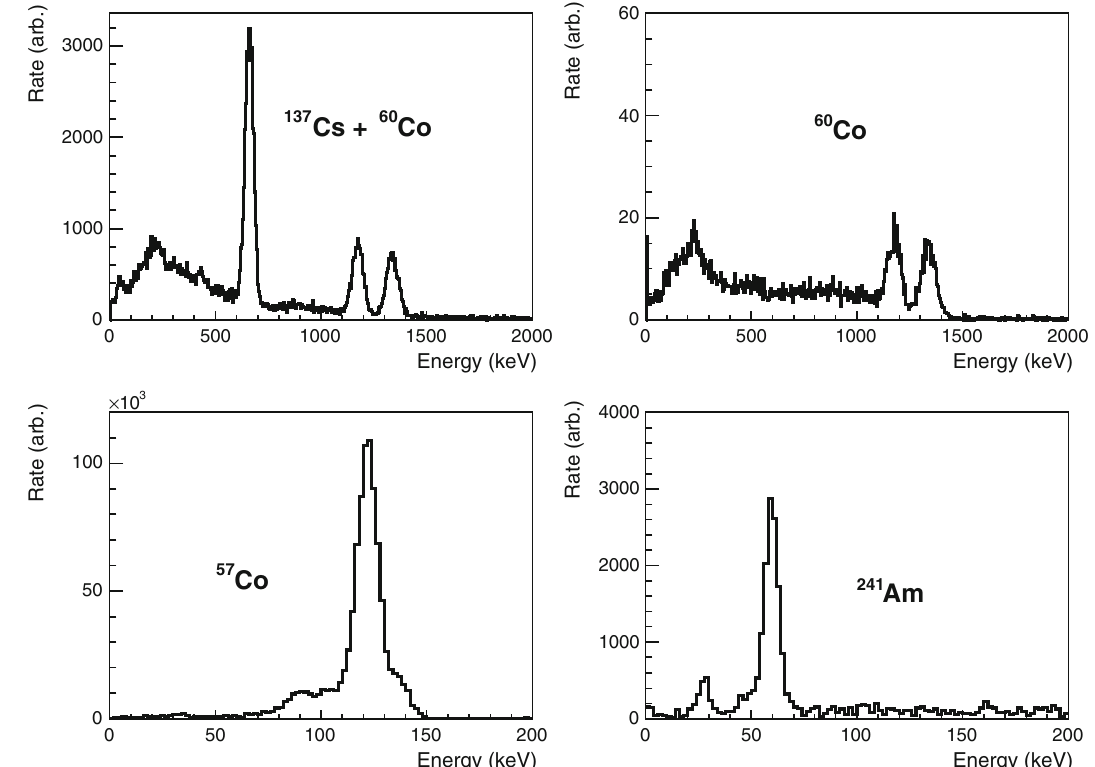
Fig. 16 The measured calibration energy spectrum in Crystal-6 for 60 Co and 137 Cs, 60 Co only, 241 Am and 57 Co calibration sources (clockwise from top